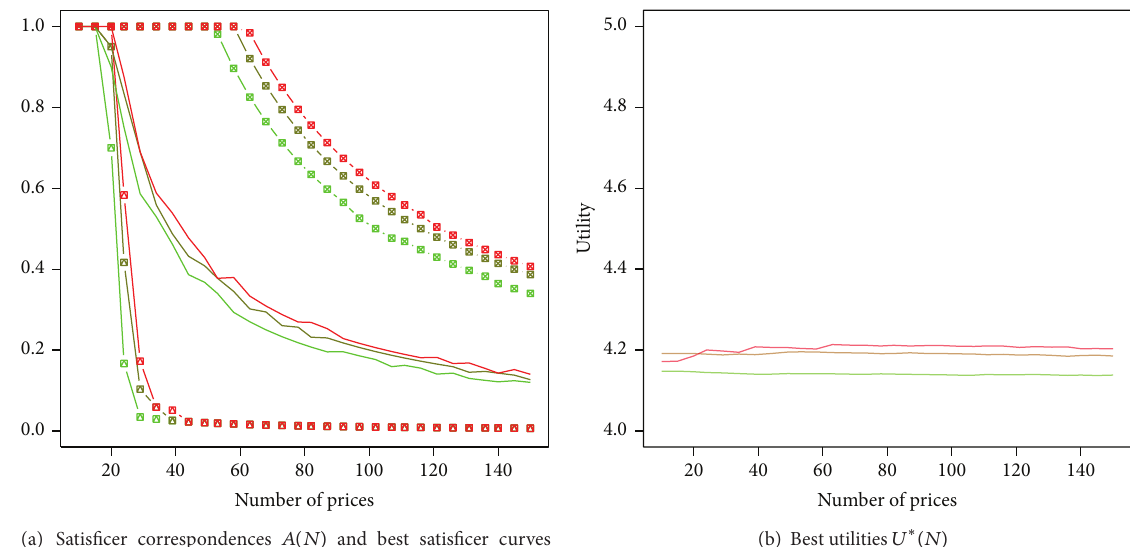
Figure 8: Analysis of satisficing behavior and welfare for mean-preserving dispersion shift under a normal distribution Color of graphs shifts from green to red as 𝜎 increases (see Table